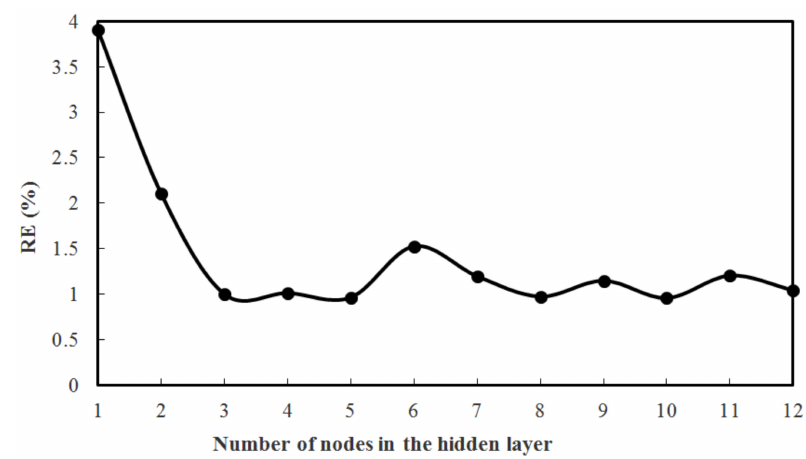
Figure 7. Performance of BP neural network with different numbers of nodes in the hidden layer.